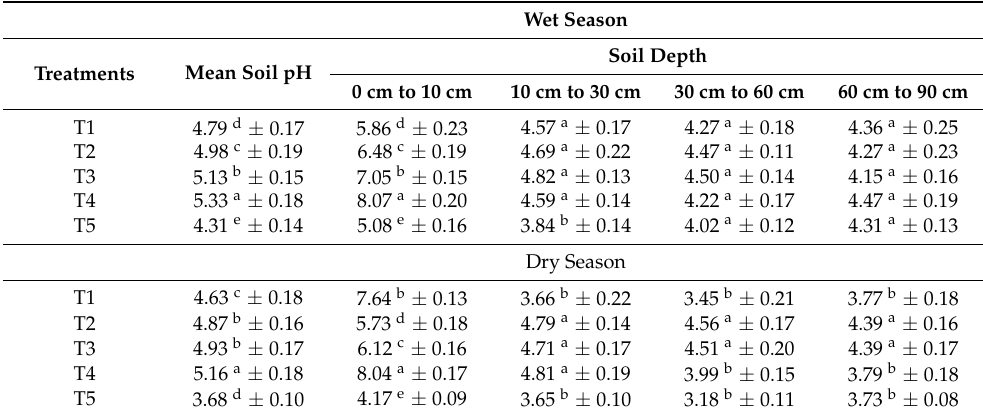
Table 4. Mean pH of peat soil in the wet and dry